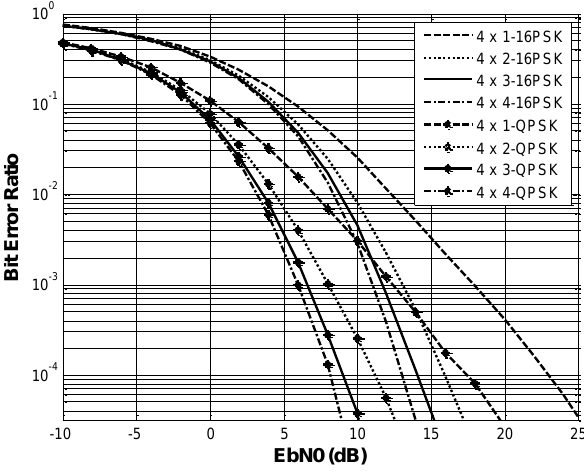
Figure 12: Evaluation of receiver diversity order for N QOSTBC